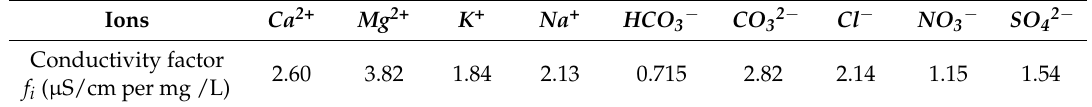
Table 3. Conductivity factors of ions in water at low concentration